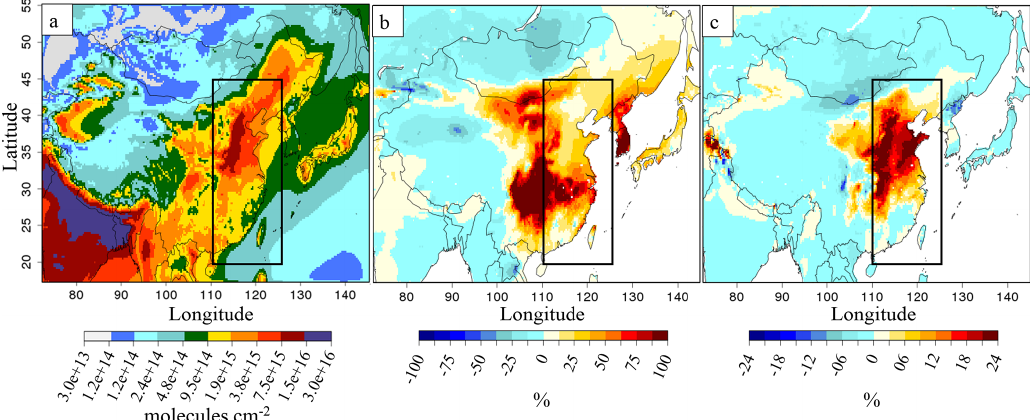
Figure 7. (a) Ammonia columns (moleculescm − 2 ) for the 2015A simulation, (b) relative differences of ammonia columns between the simulations from 2015B and 2015A, in %, and (c) additional relative differences of ammonia columns between the simulations from 2015C minus 2015B compared to 2015A, in %. The black rectangle is for the eastern China domain.